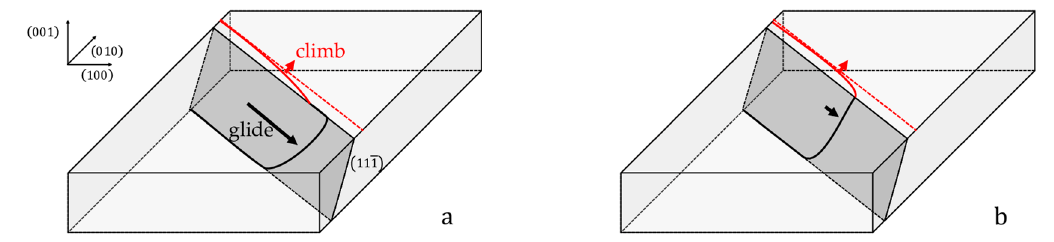
Figure 14. A dislocation glides within ( a ) 111 plane of a γ channel leaving a dislocation segment at each intersection of its glide plane and the γ / γ ’ interface. The segment at the top interface (red line) later climbs within the interface to react with another interface dislocation (red dashed line). ( b ) If the glide velocity is low the interface segment immediately bows into the interface and no extra energy is needed to create it.